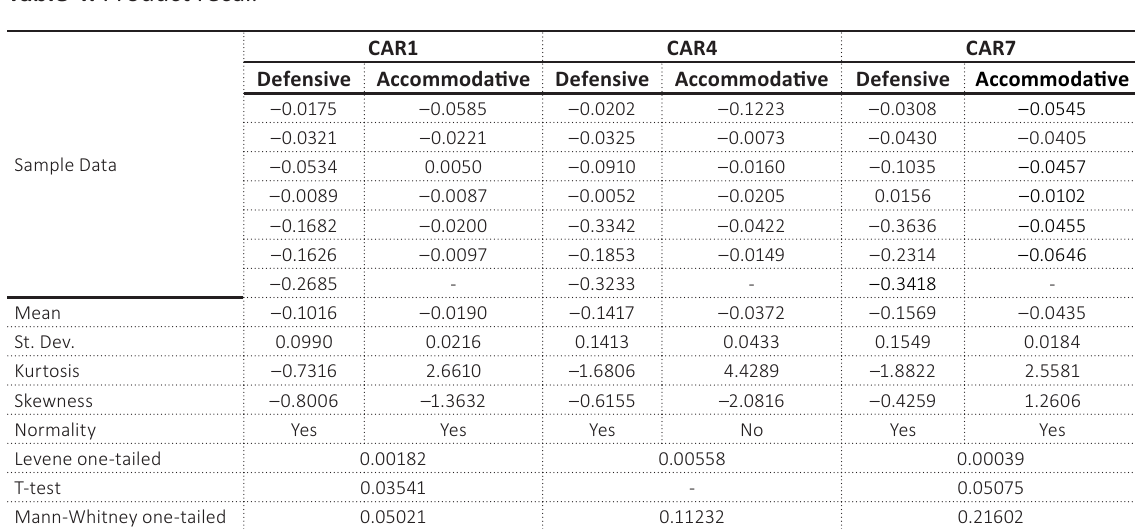
Table 4. Product recall